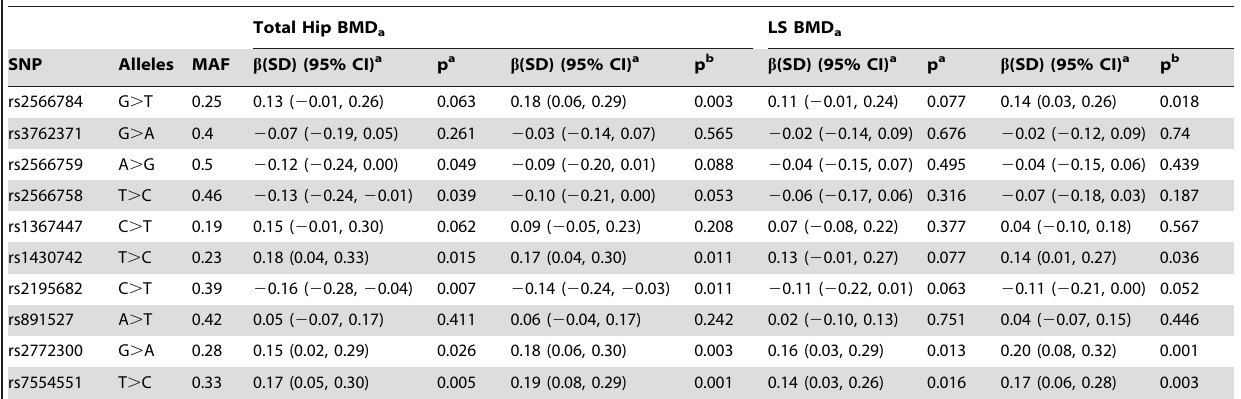
Table 2. Genetic association between GPR177 SNPs and BMD a